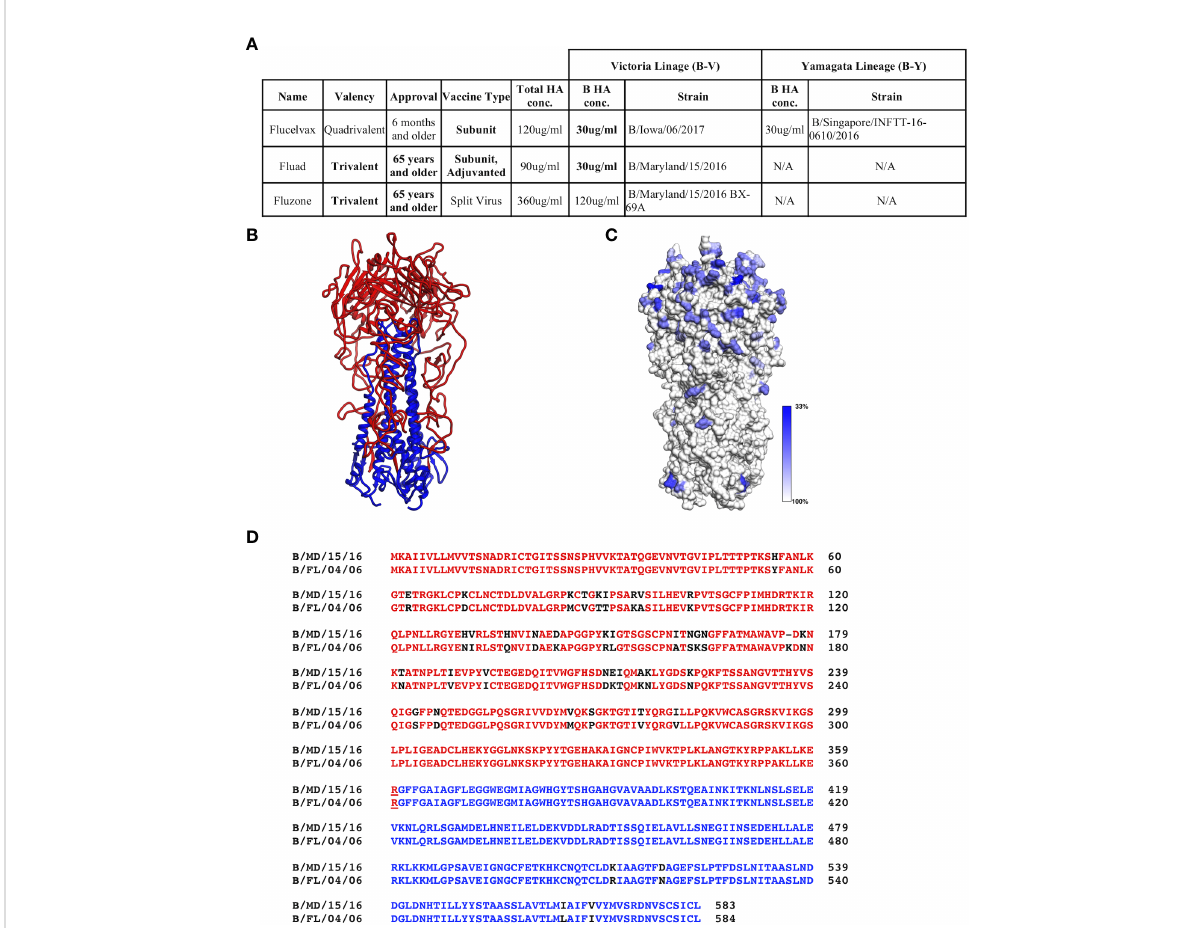
FIGURE 1 Commercial in fl uenza vaccines used in this study. (A) Strain and lineage details for the in fl uenza B HA proteins in the vaccines are provided for the 3 commercial vaccines studied: Flucelvax (Q), Fluad (T) and Fluzone (T). In fl uenza B HA of Victoria lineage is denoted as B-V, while in fl uenza B HA of Yamagata-lineage is denoted as B-Y. Both the total HA concentration and the concentration of in fl uenza B HA components are indicated. Fluad (T) and Fluzone (T) vaccines are trivalent (H1, H3, in fl uenza B HA of B-V) or quadrivalent like Fluclevax (Q) (H1, H3, B-V, B-Y HAs). H1 and H3 strains are not shown for clarity. (B) Structural coordinate model for the trimeric ectodomain for hemagglutinin of in fl uenza B (B/Florida/04/2006, B-Y). HA1 is read with HA2 in blue. (C) Conservation of amino acids between in fl uenza B HA proteins in the vaccines and other Flu B HAs used in this study mapped onto a trimeric ectodomain in panel (B) Grey is more conserved while blue more variable. (D) Example of sequence alignment between a in fl uenza B-V HA (B/Maryland/15/2016) and B-Y HA (B/Florida/04/2006). Colors represent the head (red) and stem (blue) regions of HA, residue differences are shown in black. N/A means not